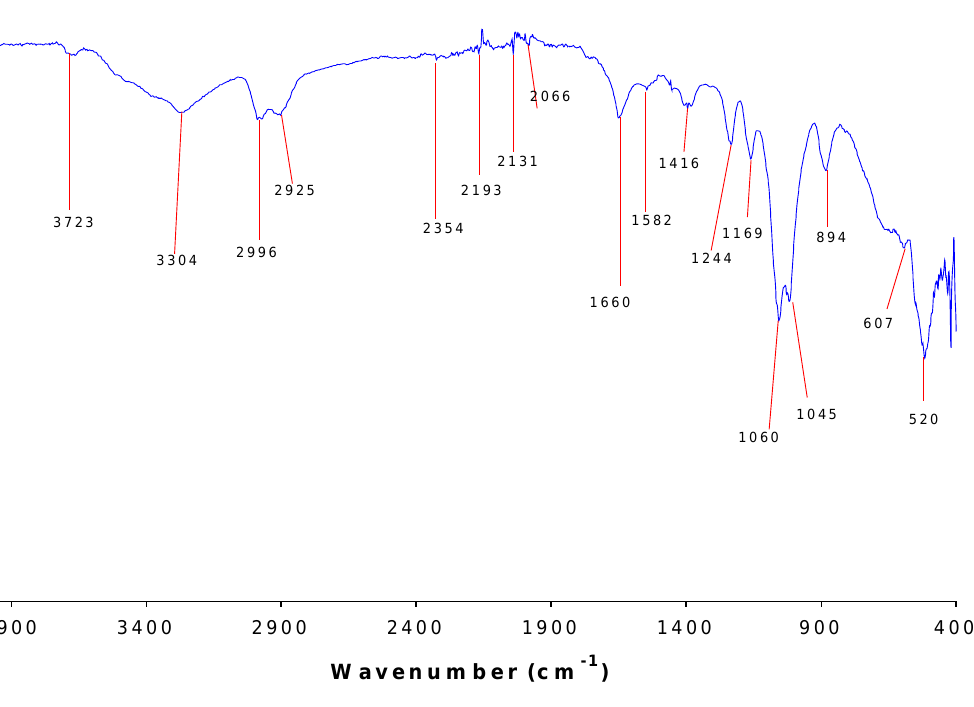
Figure 3. Infrared spectrum of the purified bioflocculant.